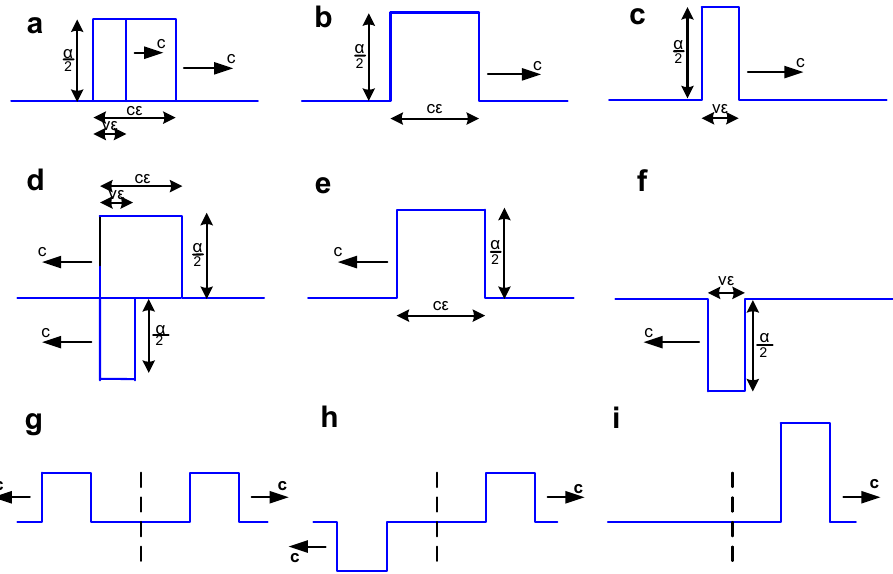
Figure 4. ( a–c ) Source motion displacement for the forward wave: ( a ) the original forward wave front pulse compared with the additional forward wave front pulse due to the source motion. ( b ) The original forward wave front pulse which is the same as the wave front pulse from the stationary source. ( c ) The additional forward wave front pulse due to the source motion. ( d – f ) Source motion displacement for the backward wave: ( d ) the original backward wave front pulse compared with the additional backward wave front pulse due to the source motion. ( e ) The original backward wave front pulse which is the same as the wave front pulse from the stationary source. ( f ) The additional backward wave front pulse due to the source motion. ( g – i ) The original and additional wave fronts with v = c . ( g ) Forward and backward wave front pulses that would propagate